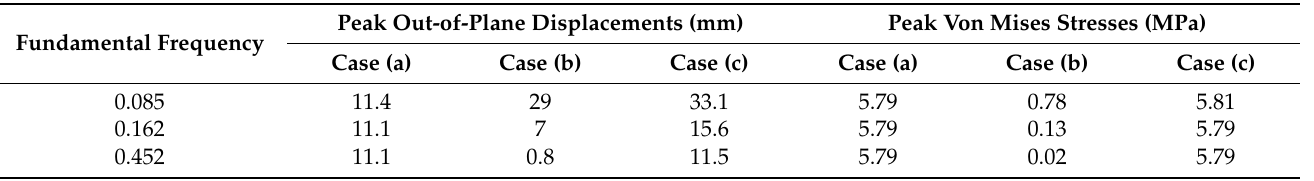
Table 4. Peak responses of the LGCW for different fundamental